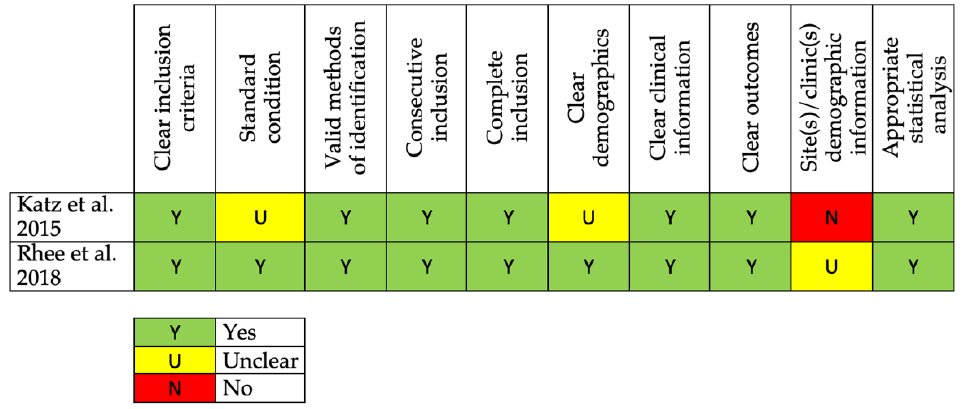
Figure 3. The risk of bias assessments for NRCTs studies [26,27,35,36,40–42].